Question: Summarize what this figure shows in one sentence.
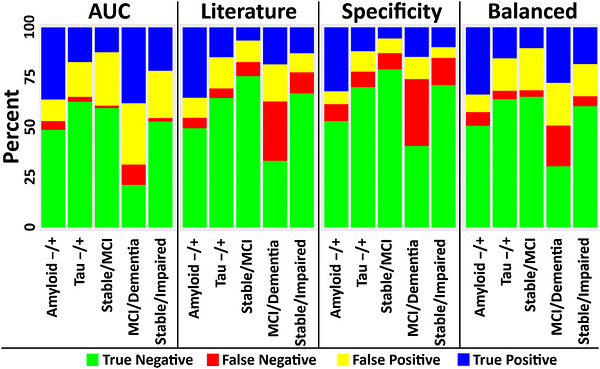
Answer: Sample sizes and demographic variables for AUC analyses across variables.